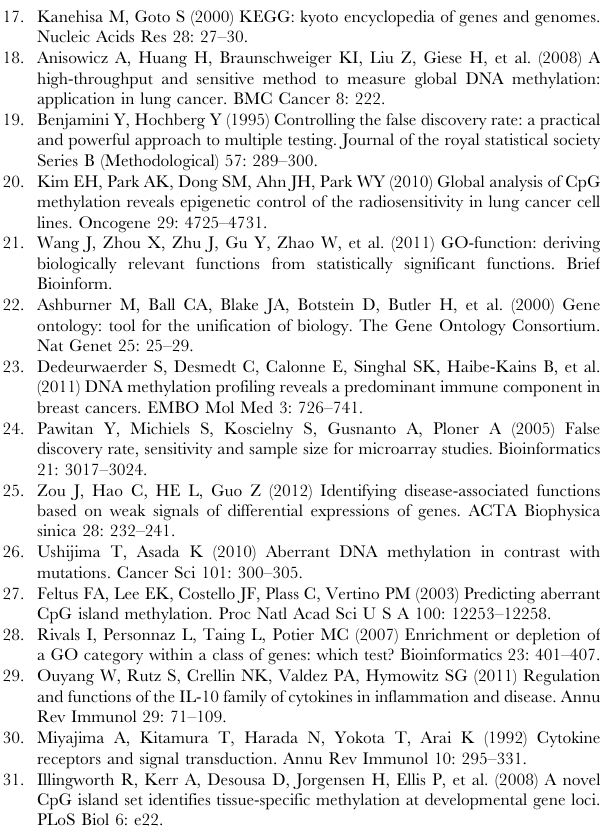
Table S2 Terms that are consistently hypomethylated across different cancer types. This table shows the 41 GO terms that are consistently hypomethylated across different cancer types with the P values of enrichment for all of the cancer types. Table S3 Hypermethylation-specific functions. This table shows the 58 hypermethylation-specific functions with the P values of depletion for all of the cancer types. Table S4 Hypomethylation-specific functions. This table shows the 24 hypomethylation-specific functions with the P values of depletion for all of the cancer types.